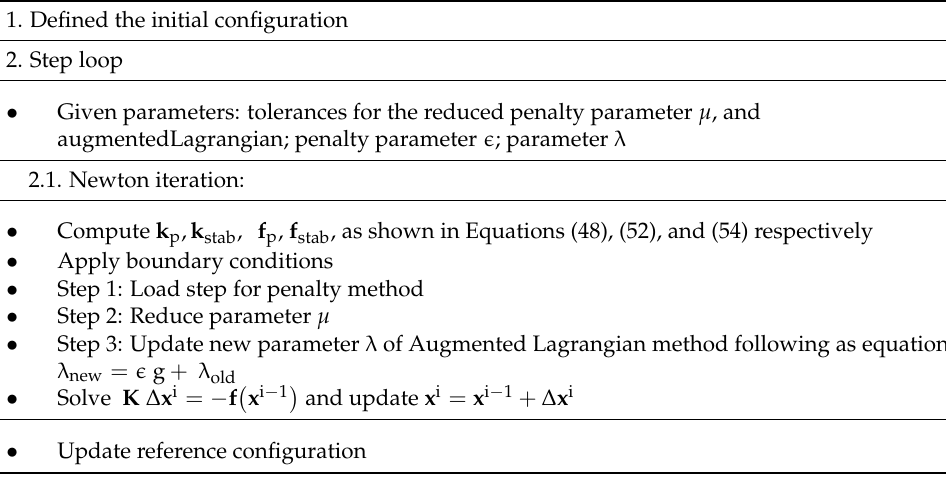
Table 1. The computational algorithm.